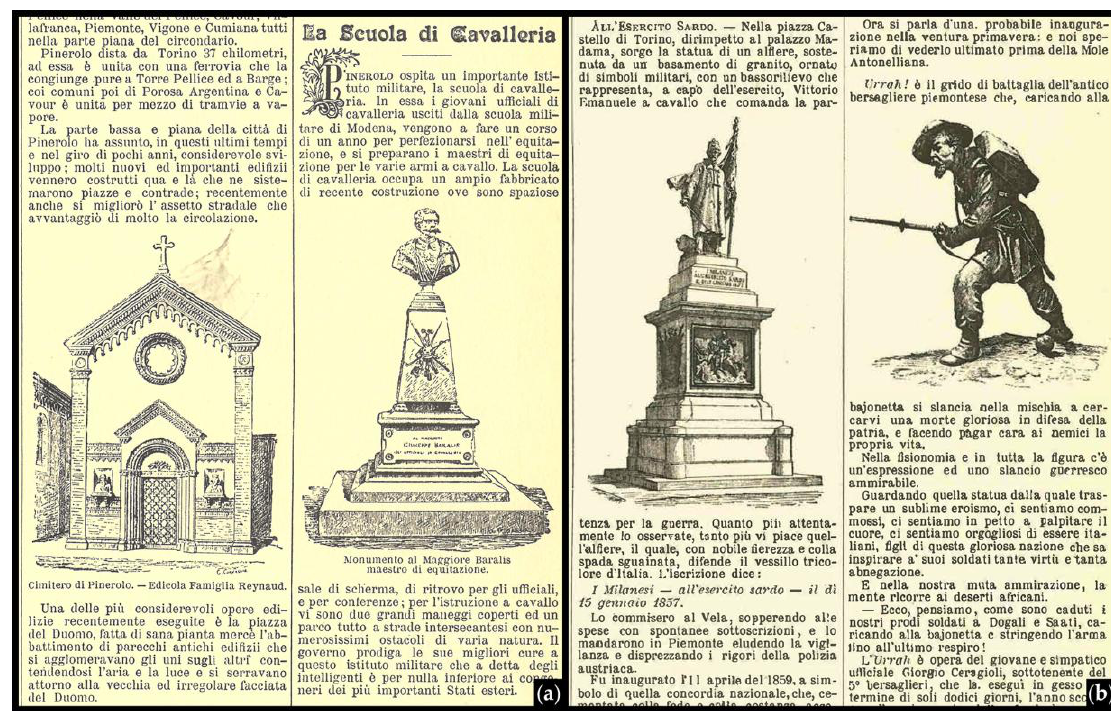
Figure 3. Examples of in text images ( a ) with captions [28] (p. 19); ( b ) without captions [26] (p.